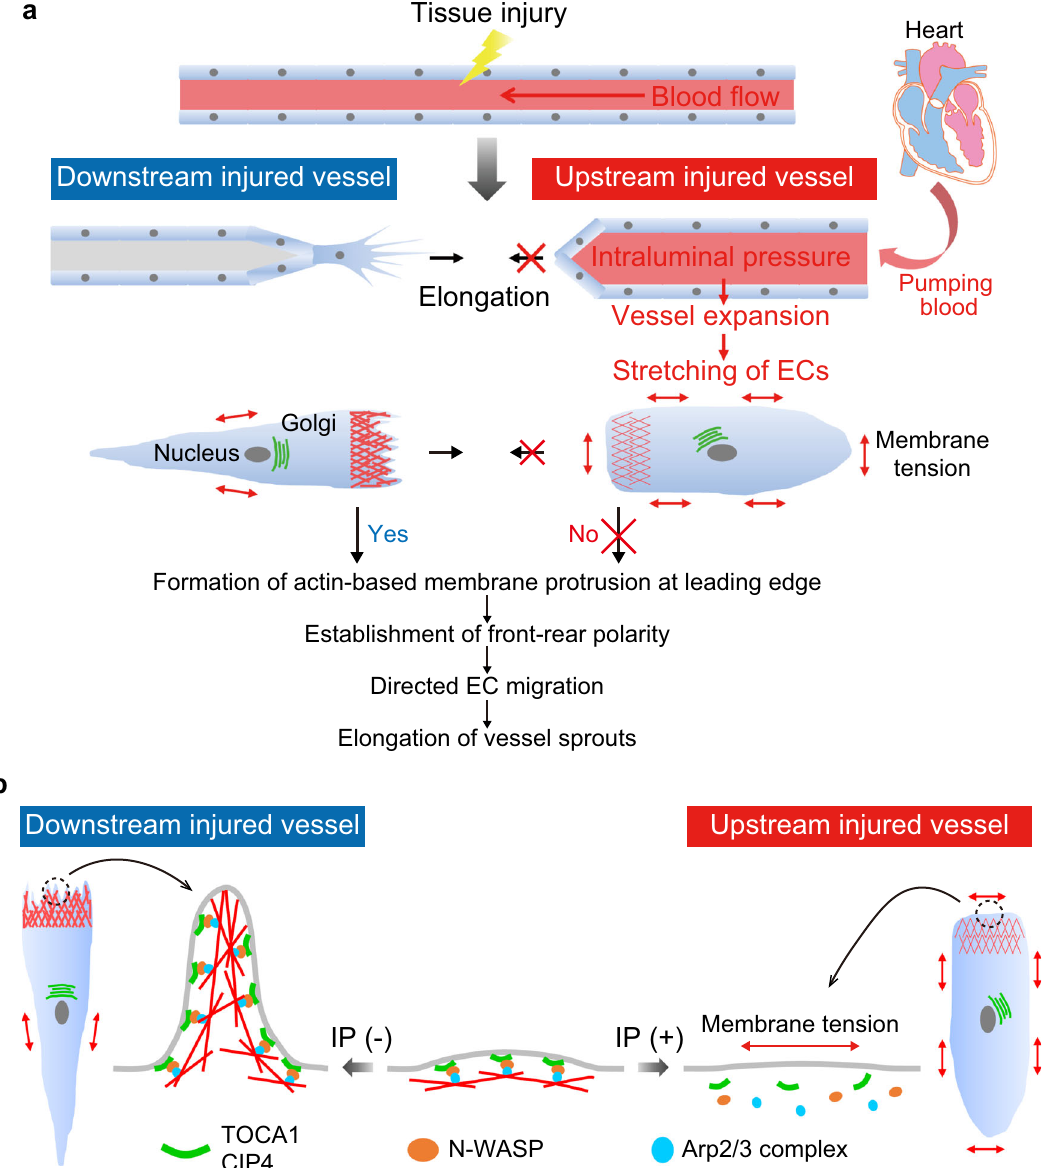
Fig. 10 Schematic representation of proposed model accounting for how blood fl ow-driven intraluminal pressure regulates angiogenesis during wound healing. a When blood vessels are damaged by tissue injury, elongation of severed blood vessels is actively induced at sites downstream from blood fl ow, whereas vessels located upstream do not elongate ef fi ciently. ECs in downstream injured vessels extend leading-edge protrusions and establish front – rear polarity to directionally migrate and elongate vessel sprouts. In clear contrast, in upstream injured vessels, IP load induces vessel expansion and EC stretching, inhibiting actin-based protrusion and front – rear polarization, thereby impairing vessel elongation. b In downstream injured vessels, TOCA1 and CIP4 bind to plasma membranes at the leading edge of ECs and recruit N-WASP and Arp2/3 complexes to induce actin-based membrane protrusion, promoting directional EC migration and vessel elongation. However, in upstream injured vessels, IP load-induced EC stretching prevents leading edge localization of TOCA1 and CIP4, thereby inhibiting actin-based protrusion and front – rear polarization, thus impairing vessel